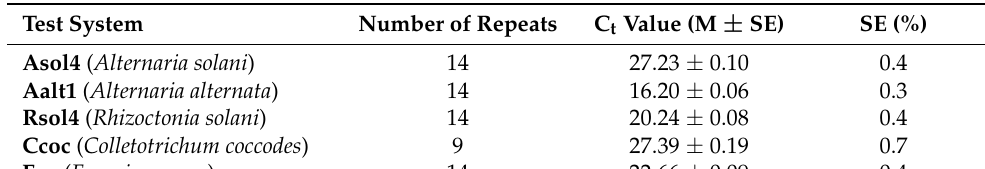
Table 5. Mean C t values obtained for the developed test systems for diagnostics of fungal pathogens of potato (reproducibility assay).